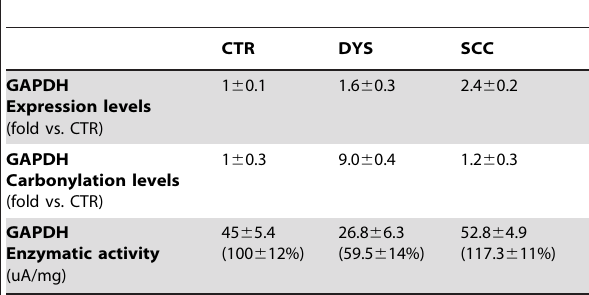
Table 4. Expression levels, carbonyl levels and enzyme activity of GAPDH in controls (CTR), dysplastic (DYS) and carcinoma tissues (SCC) are reported.